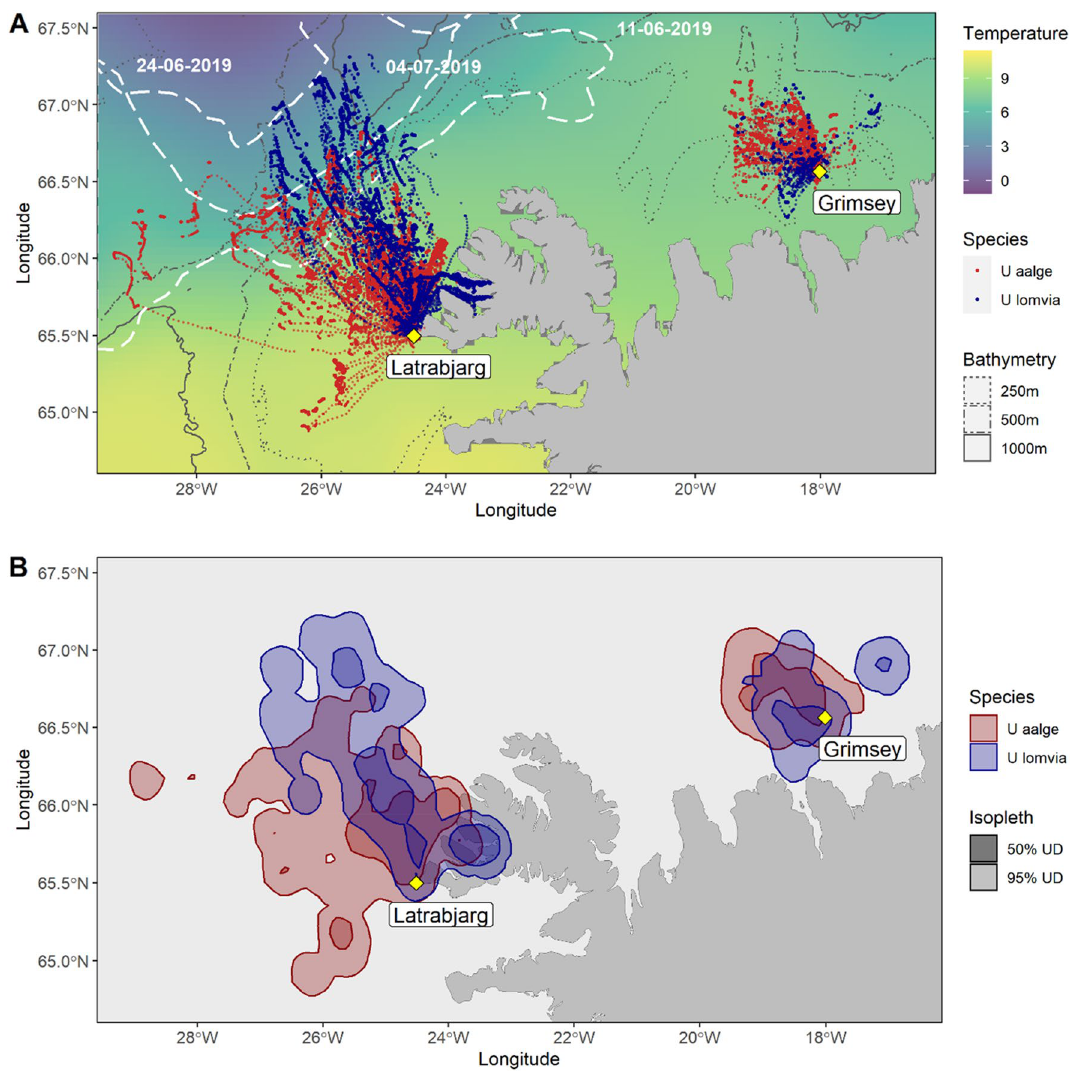
Figure 1. ( A ) Map of tracking data (small dots) and predicted dive locations (large dots), separated by species (red: common guillemot, U. aalge; blue: Brünnich’s guillemot, U. lomvia ). White lines: external limit of the Marginal Ice Zone at the start, middle and end of the study. Sea surface temperature extracted from https:// podaac- opend ap. jpl. nasa. gov: 443/ opend ap/ allDa ta/ ghrsst/ data/ GDS2/ L4/ GLOB/ JPL/ MUR/ v4.1 and averaged across the study period. ( B ) At-sea utilisation distributions (UD) and their overlap. Red: common guillemots 50% UD (dark) and 95% UD (pale); blue: Brünnich’s 50% UD (dark) and 95% UD (pale). Bandwidth for kernel calculations: 7.5 km. Yellow diamonds and labels: colony locations and names. Maps generated in R, version 4.1.1. (https:// www.R- proje ct.